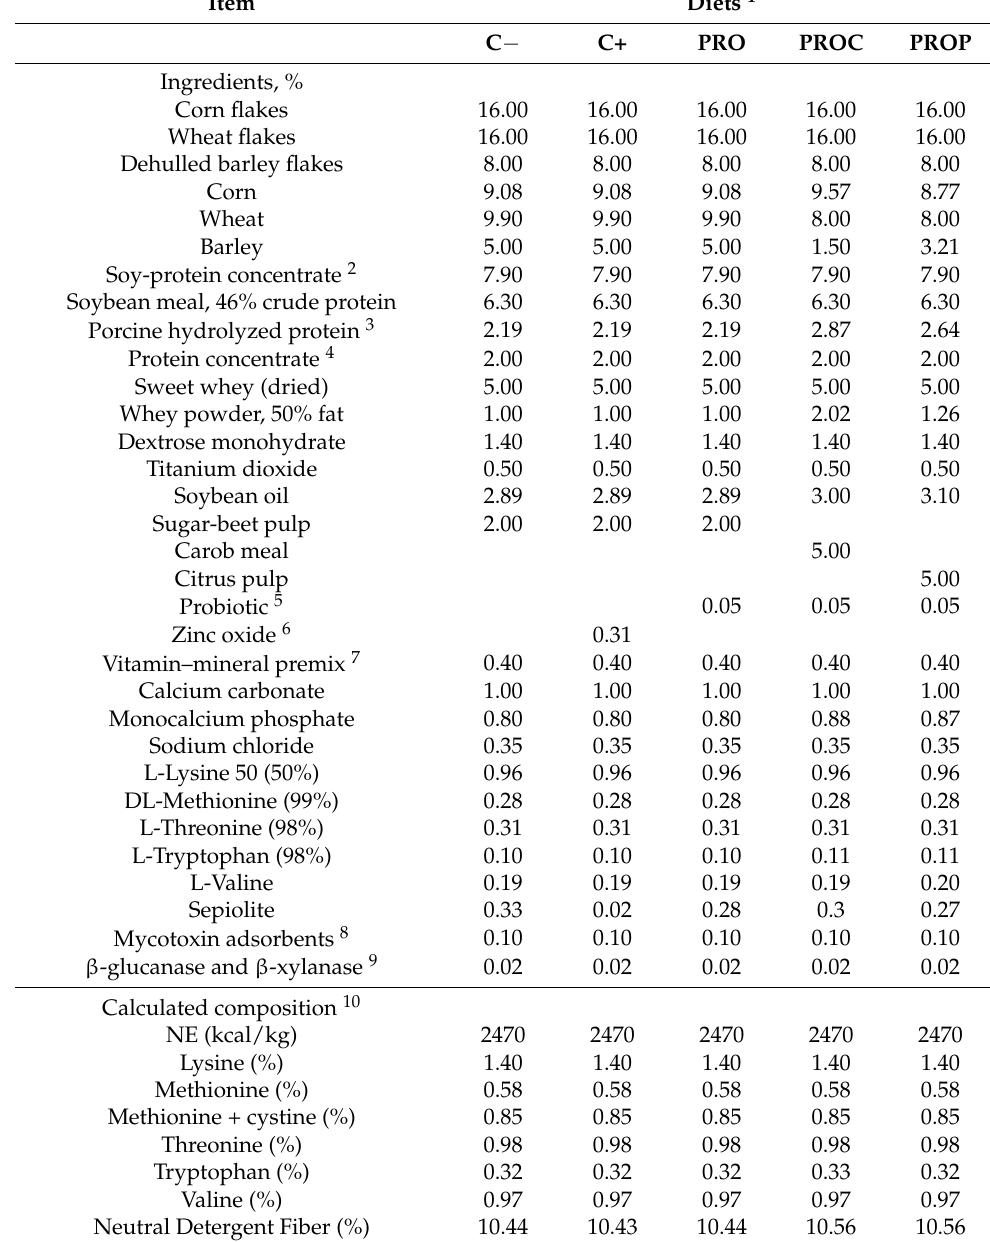
Table 1. Ingredients and composition of experimental diets (as-fed